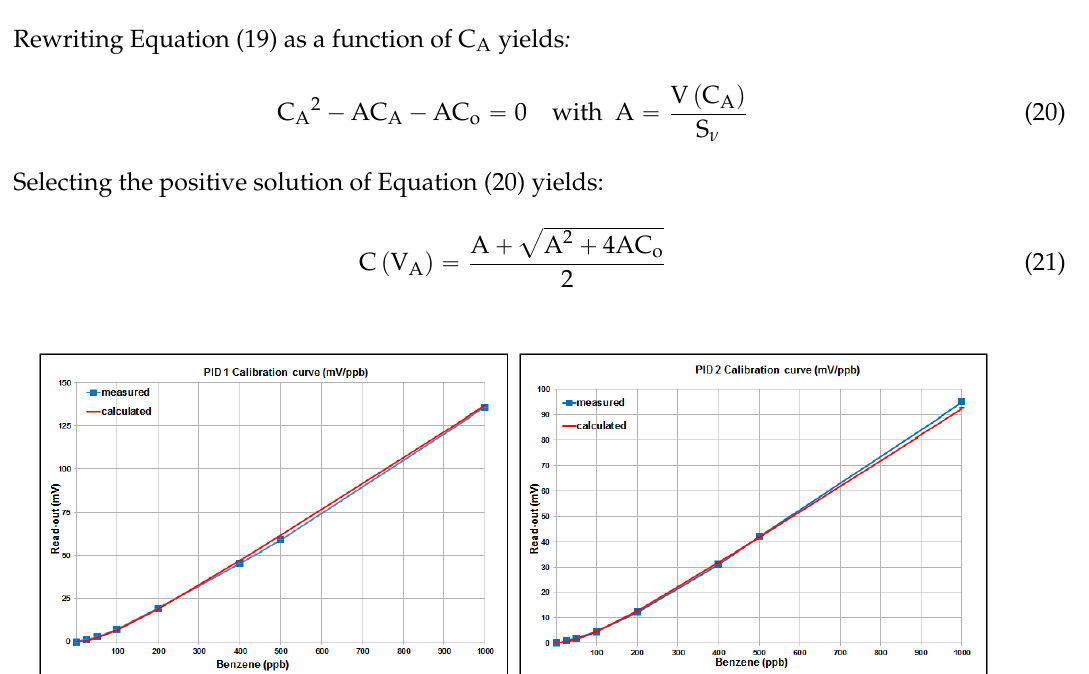
Figure 8. Calibration curves measured and calculated for the set of six PIDs. 4. Data Rendering and Experimental Results Data gathered from the field are forwarded to a central database for storage and data rendering. For this purpose, the system has a web-based interface for retrieving and displaying data and for post-processing. The interface features various formats to display the data gathered. It is possible to both access raw data and generate summary reports relating to specific periods and specific network areas. All monitored parameters can be geo-referenced. Data from individual sensors deployed in the field, either micro-climatic or VOC/H 2 S, can be accessed directly and presented in various formats. Figure 9 shows the trend of VOC/H 2 S concentration values detected by the three electrochemical sensors deployed around the wastewater treatment plant over a period of about two months (15 May 2015 to 13 July 2015). Measured values are coherently comparable to each other, demonstrating the effectiveness of the calibration procedure.